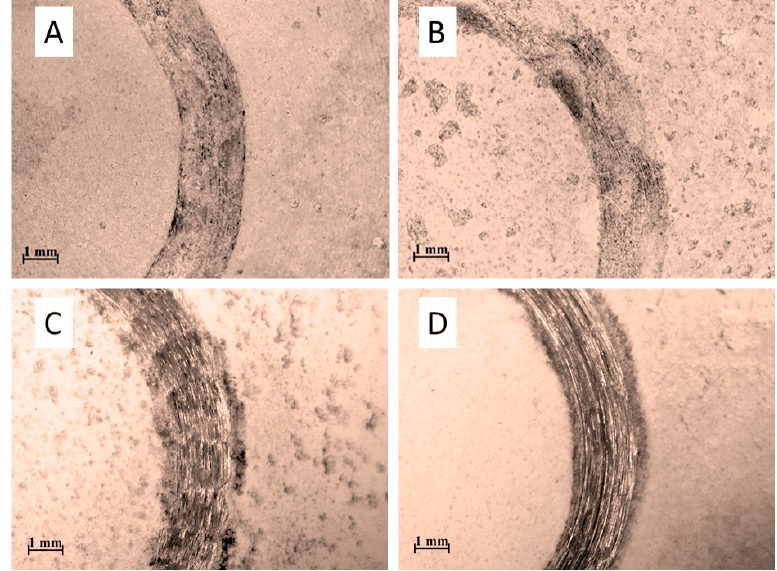
Figure 9. Stereomicroscope images of the surface of the samples after tribocorrosion test ( A ) PEO-Si; and ( B ) PEO-P; and standard wear tests ( C ) PEO-Si; and ( D ) PEO-P.